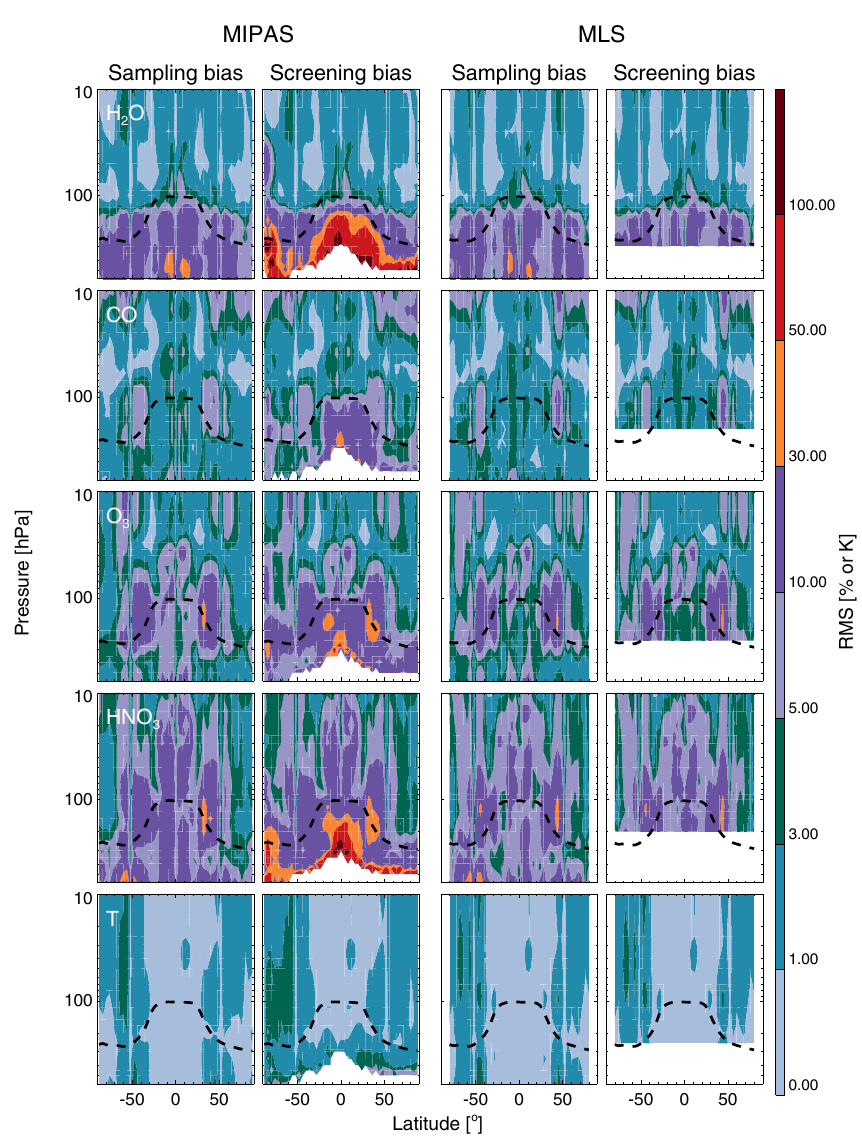
Figure 4. Root-mean-square sampling and quality screening biases for 2005 as a function of latitude and pressure for H 2 O, O 3 , CO, HNO 3 , and temperature as measured using typical MIPAS and MLS data coverage. The dashed black lines show the mean 2005 thermal tropopause derived from